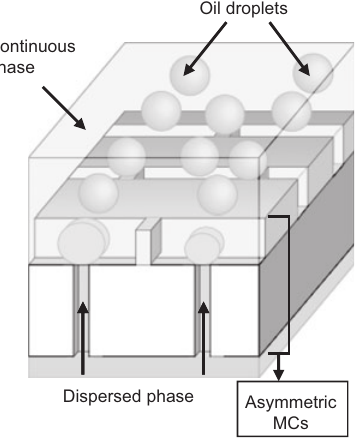
Figure 1 Three-dimensional schematic drawing of the generation of O/W emulsion droplets via asymmetric